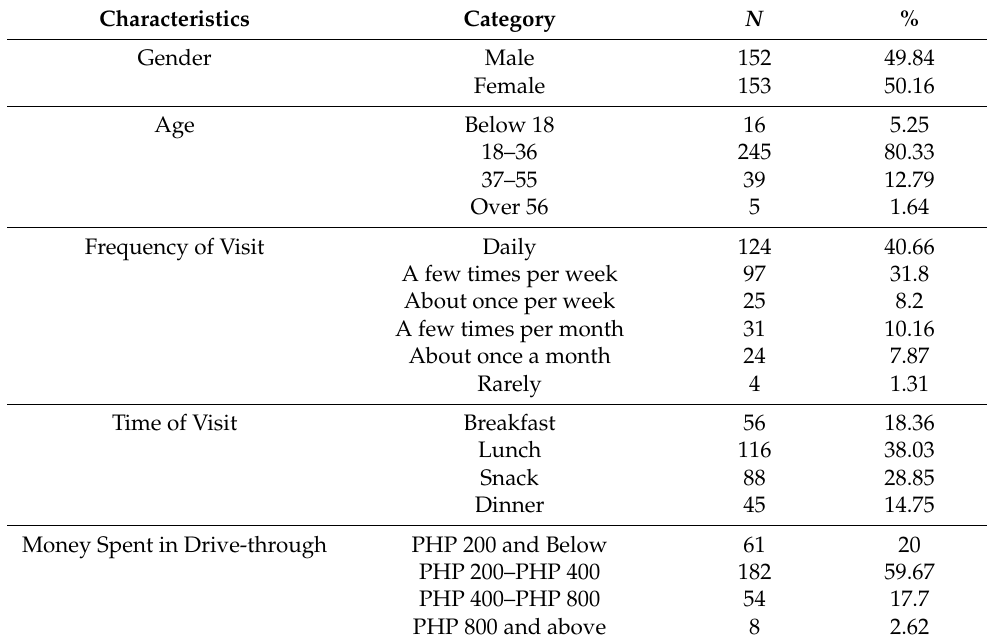
Table 2. Descriptive statistics of the respondents ( N =